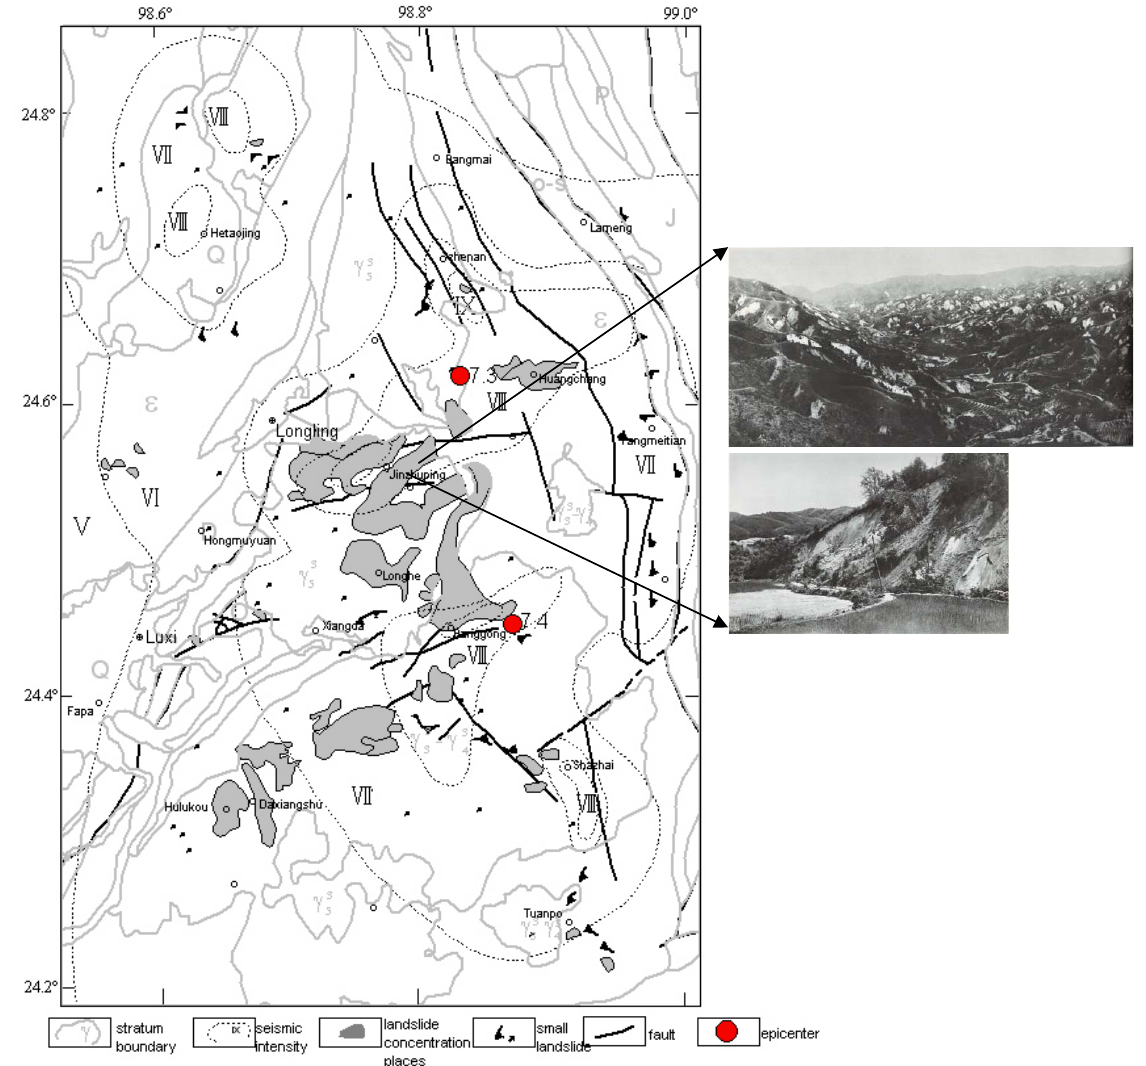
Fig 6. Geological map of Longling earthquake area and locations of earthquake-triggered landslides (revised from Institute of Geography of Sichuan province. Photos are from Institute of Geology, State Seismology Bureau)